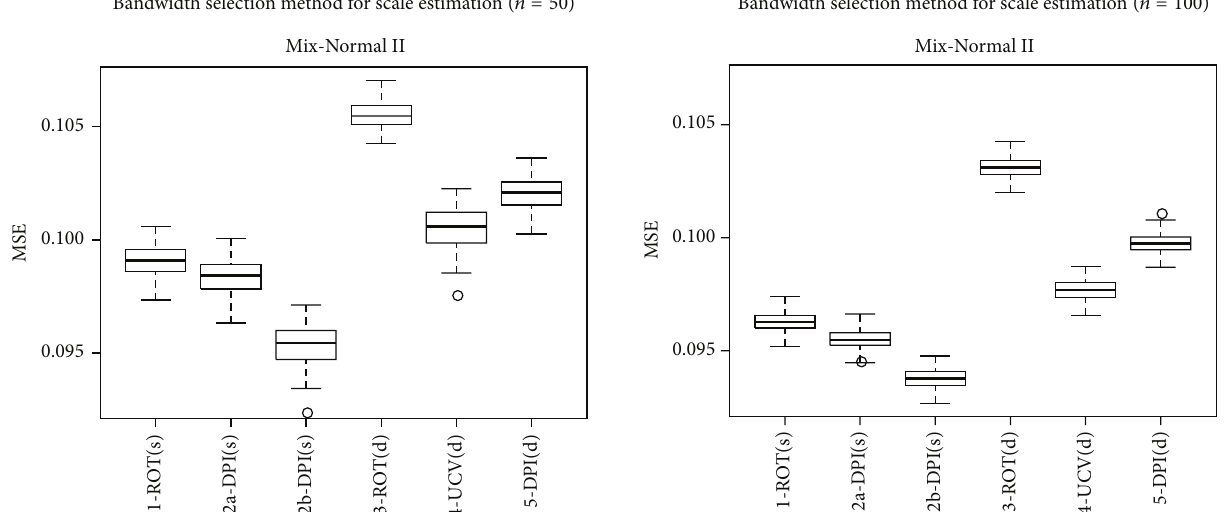
ℎ ; “1-ROT(s)” means ̂ℎ ; “3-ROT(d)” means LSCV ; density